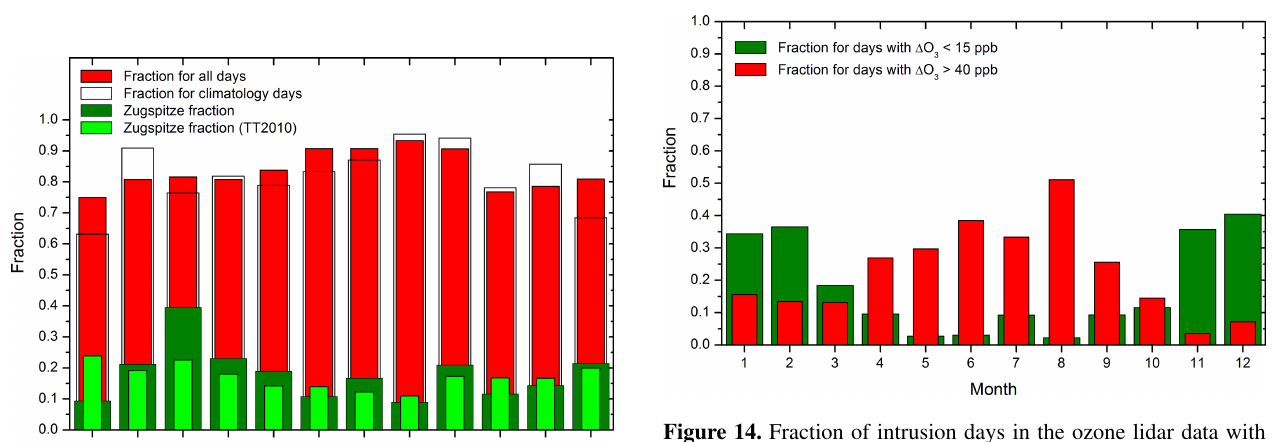
Figure 14. Fraction of intrusion days in the ozone lidar data with weak and strong ozone peaks averaged for each month between 2007 and 2016 (see